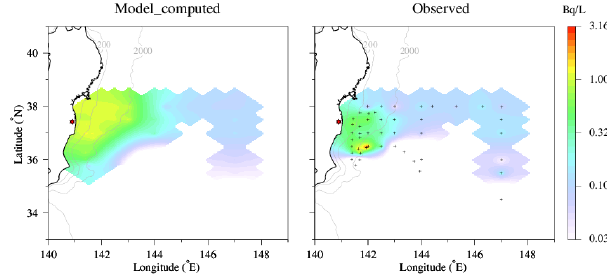
Fig. 9. Comparisons of high-resolution nested model-computed and observed (from the June WHOI survey) surface 137 Cs concentra- tions at the survey sites in June 2011. 782